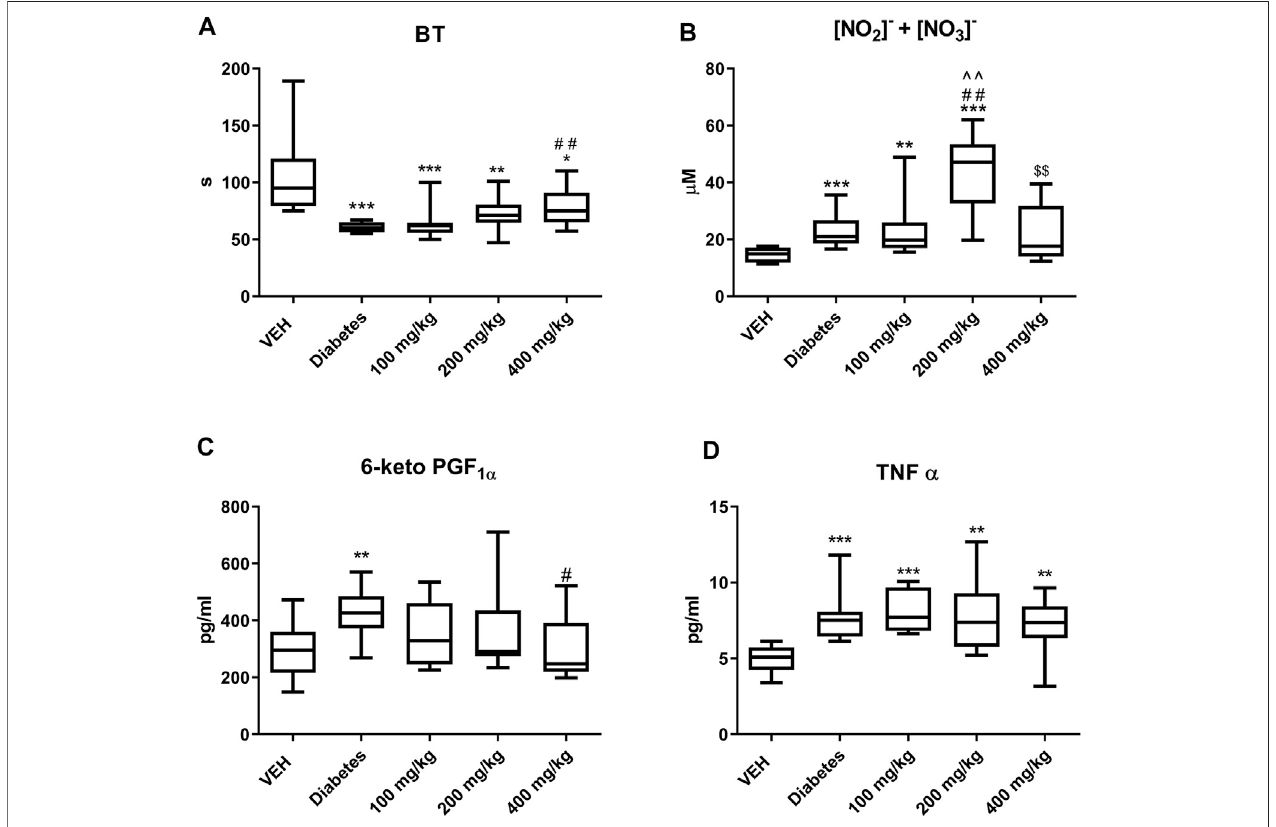
FIGURE1| TheeffectofTEon:BT (A) ,concentrationofNO 2 − and NO 3 − (B) ,concentrationof6-ketoPGF 1 α (C) ,concentrationofTNF- α (D) .* p < 0.05, ** p < 0.01, *** p < 0.001 vs. VEH; # p < 0.05, ## p < 0.01 vs. Diabetes; ^^ p < 0.01 vs. 100 mg/kg; $$ p < 0.01 vs. 200 mg/kg; n (cid:2) 8 – 11. Data are shown as median (interquartile